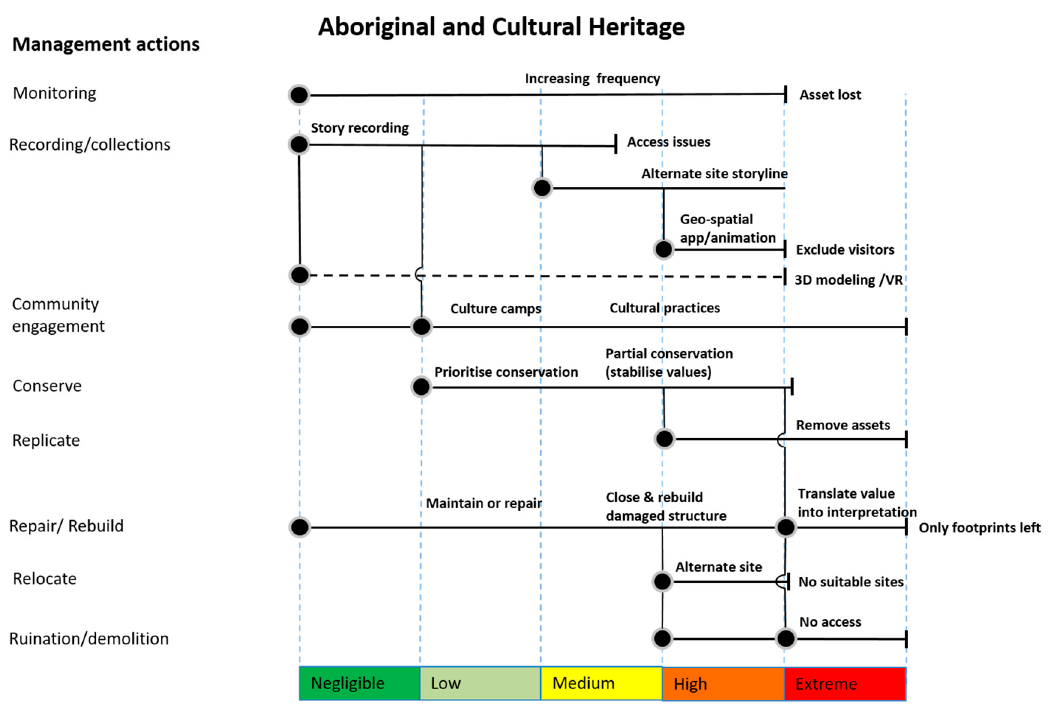
Figure 4. Adaptive management pathways under dynamic risk developed for Aboriginal and cultural heritage. Black circles represent the beginning of a pathway or result from a disjunction along a pathway. Dotted lines represent uncertainty about the continuation of a pathway at a certain risk level.